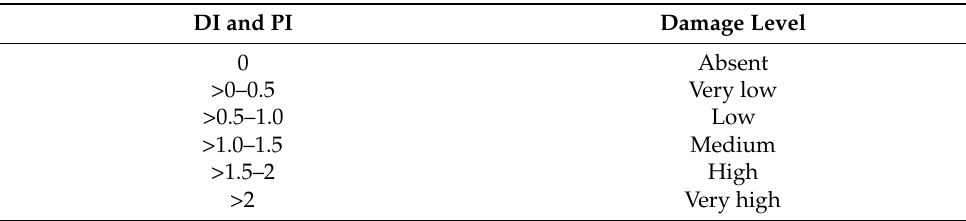
Table 3. Incidence estimated from the combination of tree damage intensity (DI) and plot infestation rate (PI)